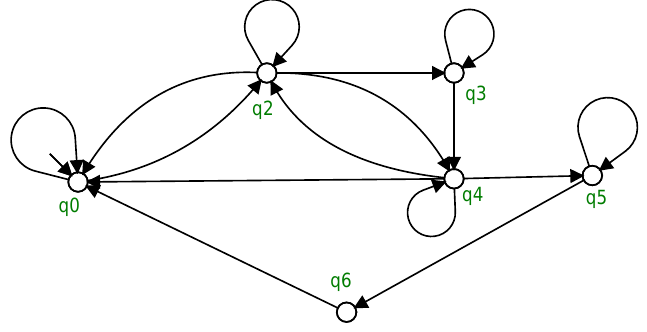
Figure 11. Learned model of the